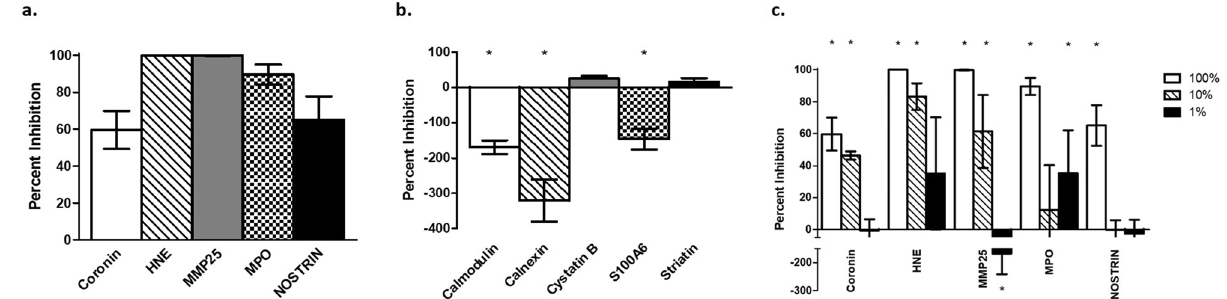
Figure 2. Cryptococcal Inhibition by Lysosomal Proteins. C. neoformans strain H99 yeast cells were grown in YPD broth for 18 h in a 30 °C shaking incubator, then washed and adjusted to a concentration of 1 × 10 5 cells/ ml. Fungi were incubated in phosphate buffer alone (pH 5.5) or in phosphate buffer with each protein for 24 h at 37 °C, 5% CO 2 , and percent inhibition defined as 100%—(test CFUs/control CFUs) × 100%. Data shown are means ± standard error of the mean (SEM) of the percent inhibition of three independent experiments (n = 3), with each condition performed in triplicate. ( a ) Lysosomal proteins that showed significant cryptococcal inhibition (*) compared to H99 in phosphate buffer alone as indicated by two-tailed t-tests ( p < 0.0001 for all). ( b ) Lysosomal proteins that showed no cryptococcal inhibition or significantly enhanced growth (*) by two- tailed t-tests when compared to H99 in phosphate buffer alone ( p = 0.0034 for S100A6, p < 0.0001 for calmodulin and calnexin) . ( c ) Reduced concentrations of select lysosomal proteins with white bars, striped bars, and black bars indicating protein concentration at 100%, 10%, and 1%, respectively. Two-tailed t-test comparing fungal growth with protein against growth in phosphate buffer alone confirmed significant inhibition (*) at 10% for coronin ( p < 0.0001), HNE ( p < 0.0001), and MMP25 ( p = 0.0008). MPO showed significant inhibition at 1% (p = 0.0213) but not 10% while NOSTRIN was not able to reduce growth at any of the lower concentrations. At 1% original concentration, MMP25 significantly ( p = 0.0010) increased cryptococcal